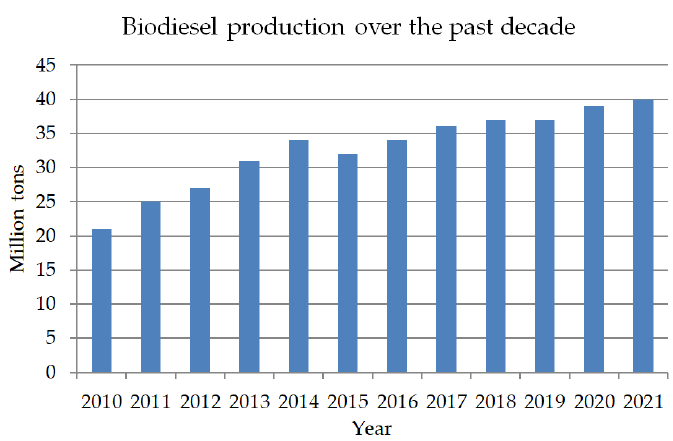
Figure 1. Biodiesel production over the past decade.